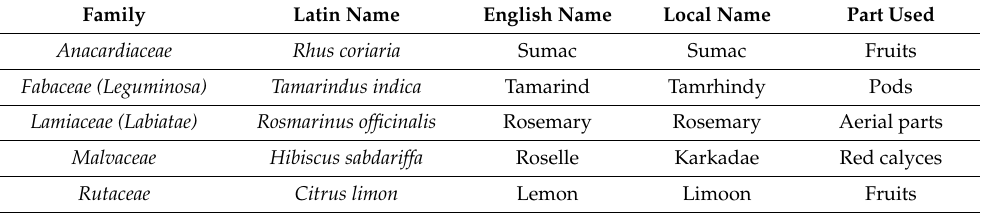
Table 1. A list with the Latin names, English names, local names and used parts of the medicinal plants